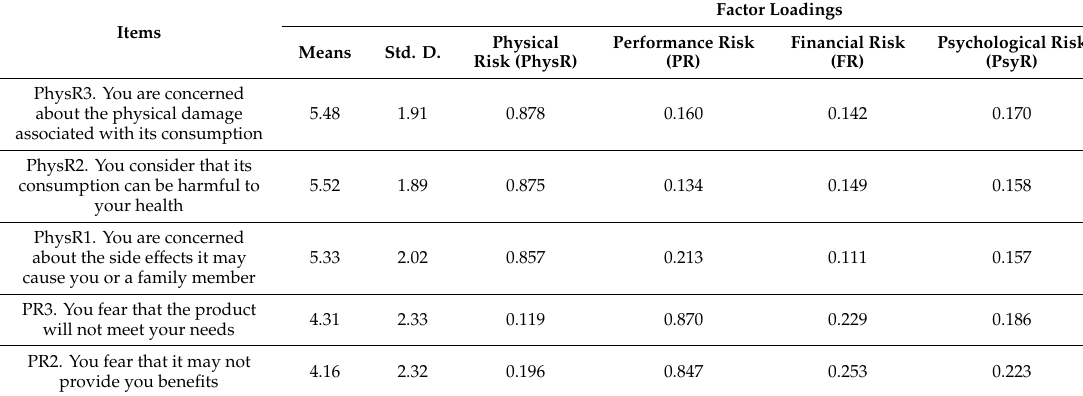
Table 2. Exploratory factor analysis for the dimensions of perceived risk and intention to avoid